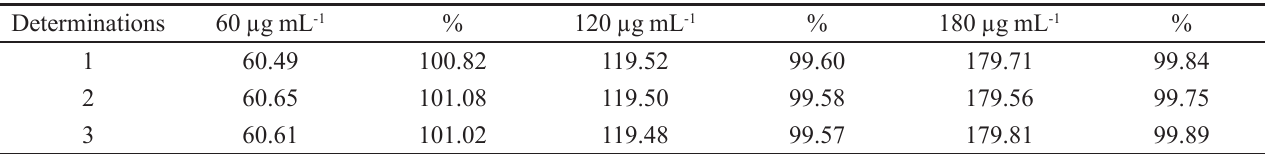
TABLE III – Results of robustness for the parameters evaluated: manufacturer of methanol and shaking time Parameters